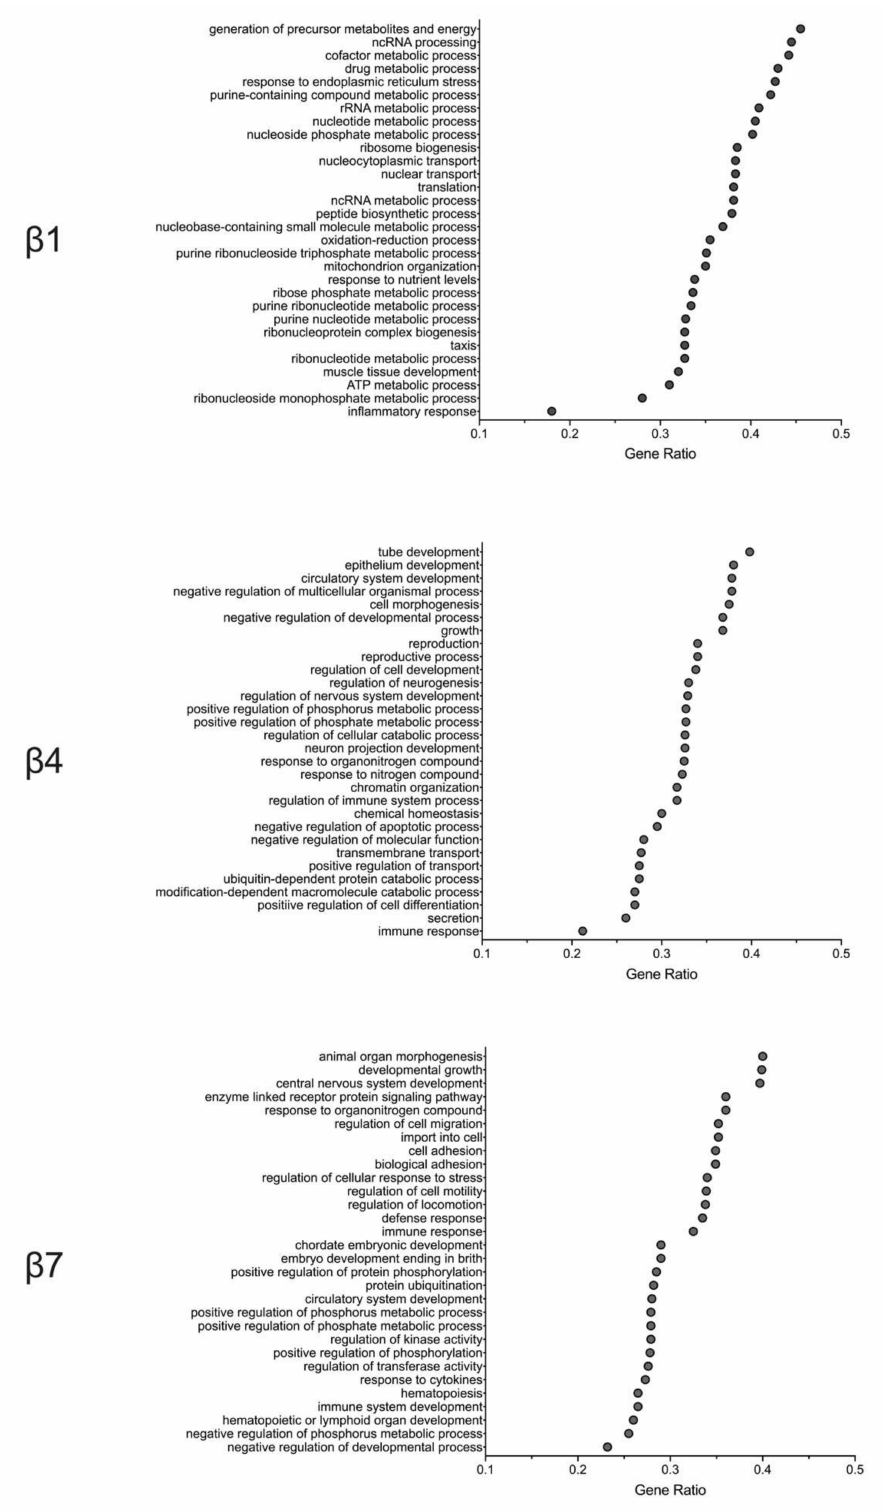
Figure 3. Altered signaling pathways of the minor β -cell clusters. Gene ontology gene set enrichment analysis (GO GSEA) was performed after single-cell RNA sequencing to evaluate the signaling pathways specifically altered by high-fat-diet feeding vs. low-fat-diet feeding in di ff erent β -cell clusters. Shown are the GO GSEA analyses of β 1, β 4, and β 7 cell